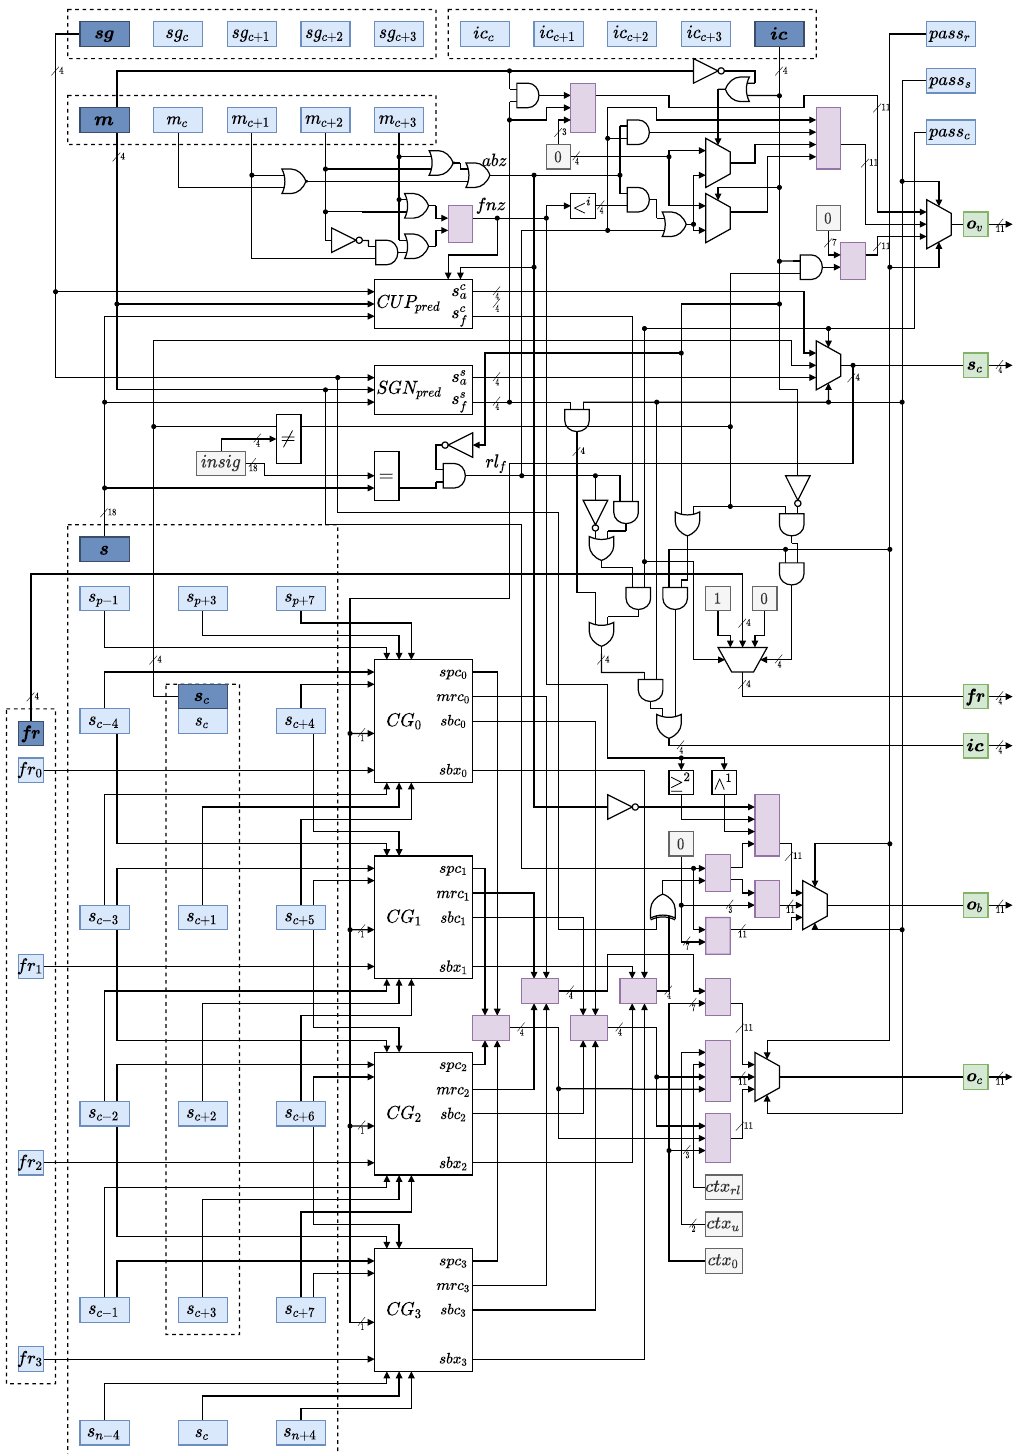
Figure 6. BPC structure. sg indicates sign bits for the current strip. m indicates magnitude bits for the current strip. ic is the coded flag for the strip, indicating whether each bit is coded. fr is yet another flag indicating, for each bit, whether it is being refined for the first time. s is the significance status for the neighborhood of the strip. pass x are flags indicating the current pass (significance, cleanup, refinement). Flags are updated for the next pass and output to memory. The contexts for each pass exit the context generation ( CG ) modules for all three passes ( spc , mrc , sbc ) along with the xor bit for the sign. This ends up being output as a vector of triplets o c , o b , o v , containing the context–data (CxD) pairs as well as a valid